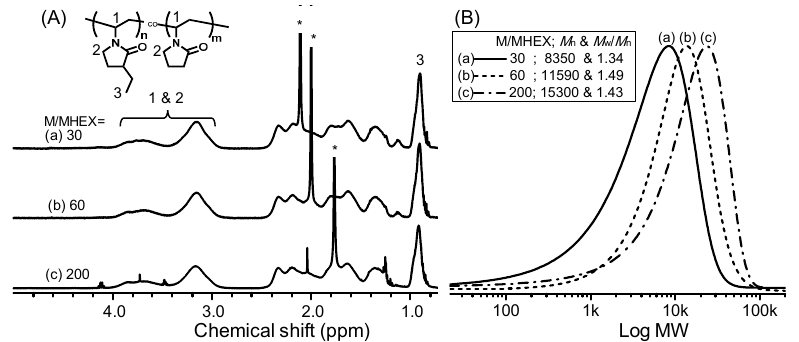
Figure 1. C1–C3 copolymers of ( A ) 1 H NMR spectra (400 MHz, CDCl 3 ); ( B ) GPC traces through RAFT copolymerization of N -vinylpyrrolidone (NVP)and 3-ethyl-1-vinyl-2-pyrrolidone (C 2 NVP) with different M/MHEX ratios (*: impurities).